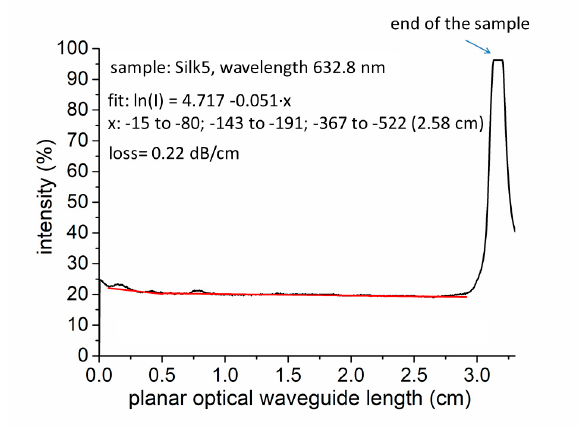
Figure 8. The optical losses of the silk deposited on a glass substrate (silk #2).